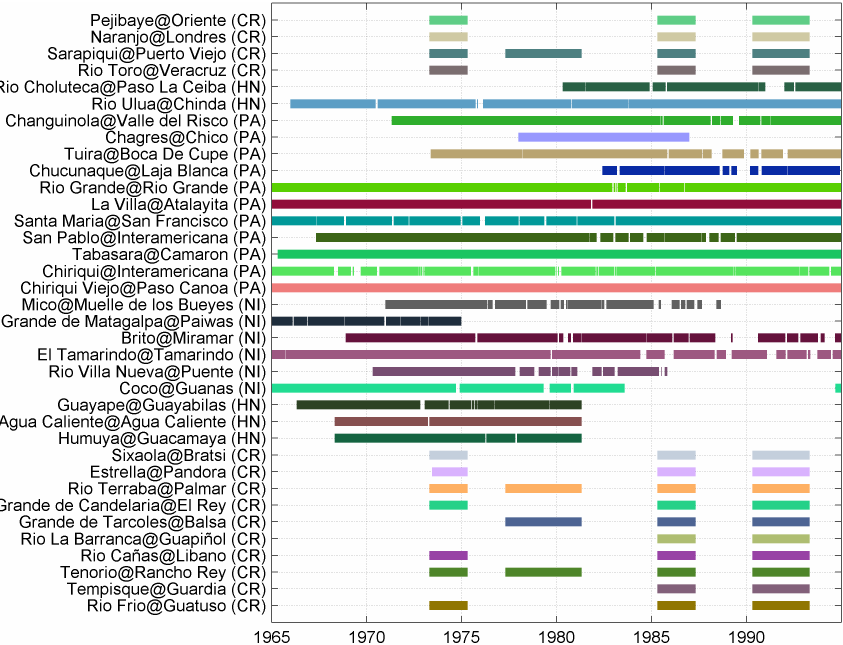
Figure 2. Temporal availability of data for each discharge station, country codes in parentheses (CR=Costa Rica, HN=Honduras, NI=Nicaragua, and PA=Panama).